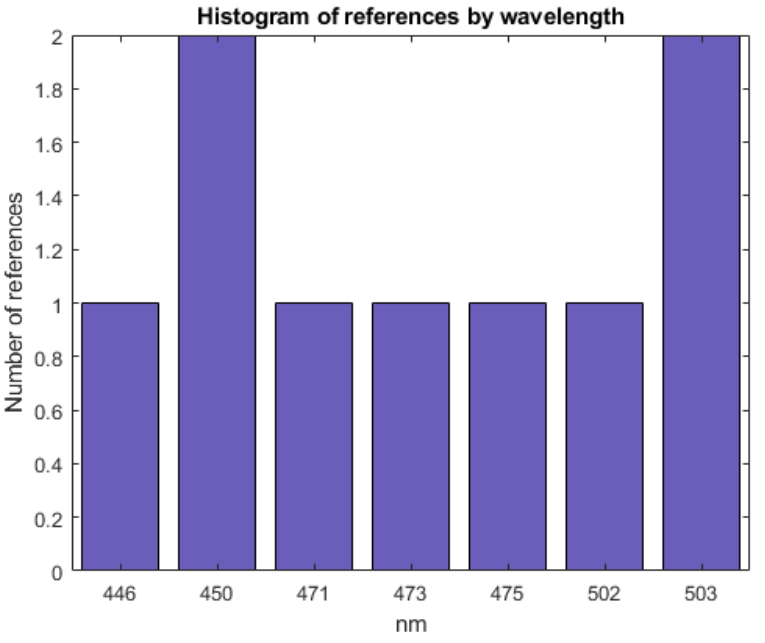
Figure 12. Range of the electromagnetic spectrum most used to detect lycopene.